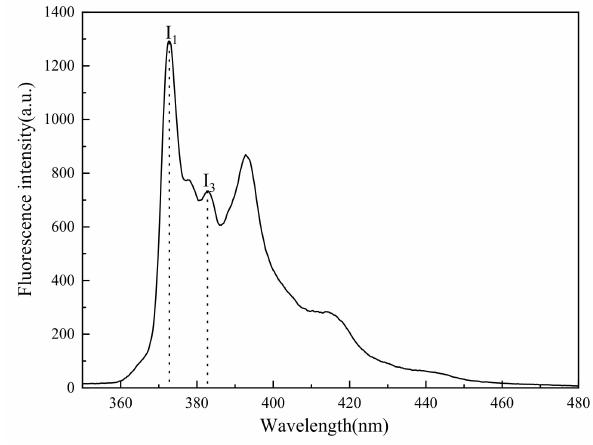
Figure 14. Fluorescence spectra of pyrene in deionized